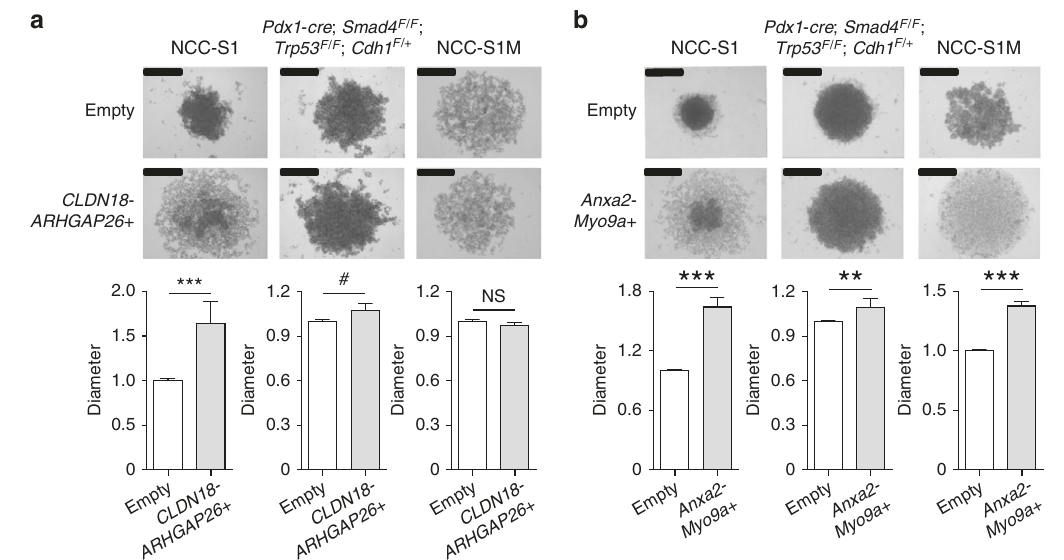
Fig. 3 Effect of fusions on the aggregation and proliferation of DGC cells ( a ) Slow aggregation assays of mouse DGC cells that stably expressed CLDN18- ARHGAP26 . Top panels, representative photographs (scale bar = 0.5 mm); Middle panels, cell aggregate diameter of DGC cells that stably expressed CLDN18-ARHGAP26 relative to cells expressing an empty vector. Average values for at least three independent experiments. Error bars, mean ± SEM. ( b ) Slow aggregation assays of mouse DGC cells that stably expressed Anxa2-Myo9a . Top panels, representative photographs (scale bar = 0.5 mm); Middle panels, cell aggregate diameter of DGC cells that stably expressed Anxa2-Myo9a relative to cells expressing an empty vector. Average values for at least three independent experiments. Error bars, mean ± SEM. # P < 0.05, * P < 0.01, **P < 0.001, *** P < 0.0001, paired t